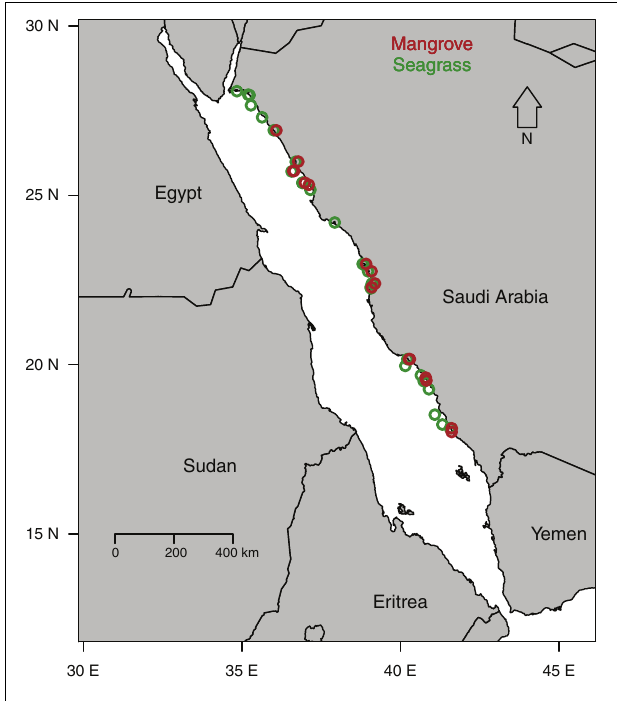
FIGURE 1 | Map showing the location of seagrass (green circles) and mangrove (brown circles) study